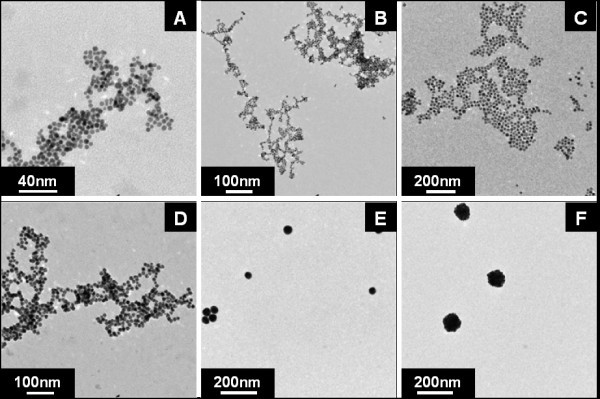
TEM images of AuNPs synthesized by CO reduction of HAuCl4. A, B, C, and D are TEM images of AuNPs synthesized without the addition of K2CO3. E and F are AuNPs synthesized from a hydrolyzed solution of aqueous HAuCl4 via the addition of K2CO3. The corresponding sizes of the AuNPs are 4, 6, 15, 25, 50, and ~100 nm respectively.